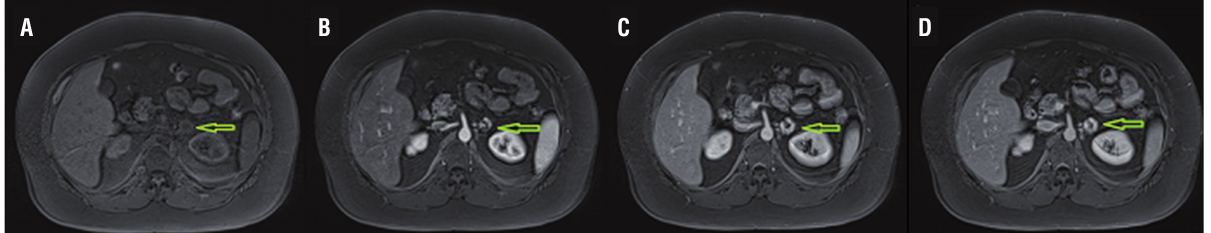
figure 1 - Magnetic ressonance with axial T1wI image in phases before contrast (A), arterial (B), portal (c) and Equilibrium (D), showing a heterogenous nodule, hypervascularized, with peripheral progressive highlight due to contrast at the retroperitoneum, measuring